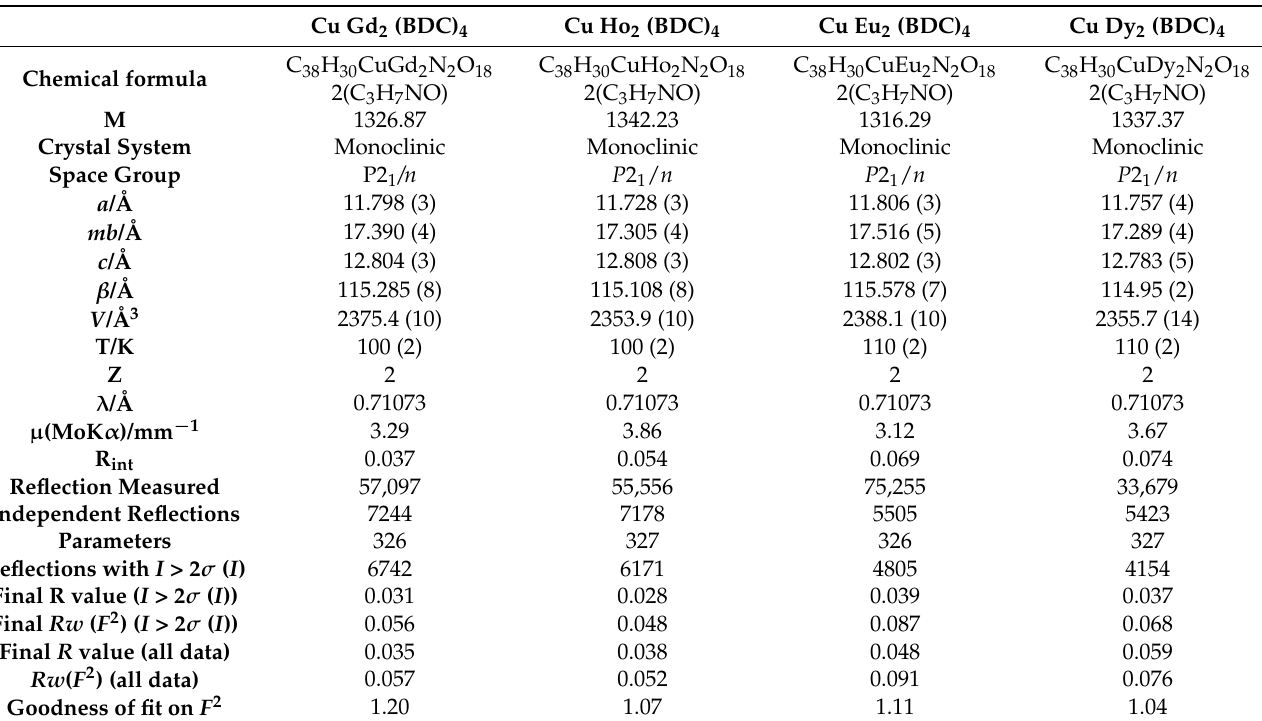
Table 1. Single-crystal XRD data for compounds 1 , 2 , 3 , and 4